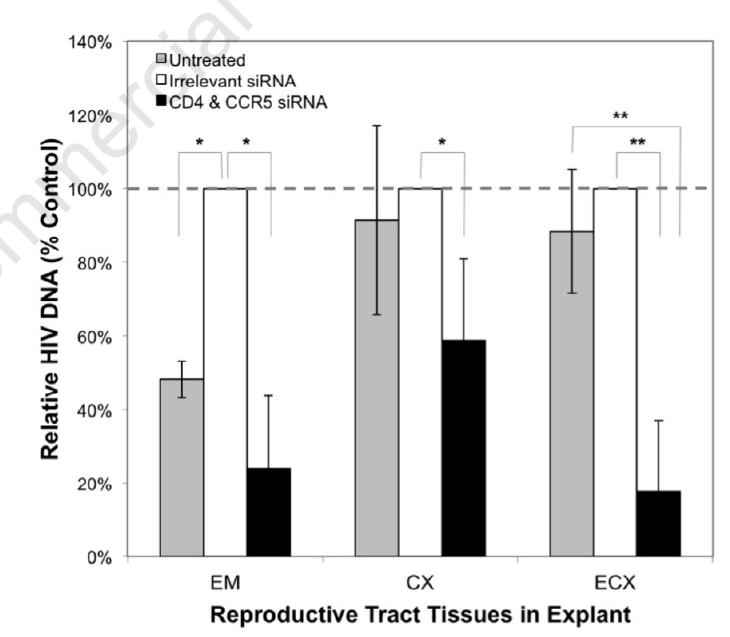
Figure 4. Nanoparticles containing CCR5 and CD4 specific siRNAs inhibit HIV-1 reverse transcription in female reproductive tract explants. Female reproductive tract tis- sue explants from the endometrium (EM), endocervix (CX) and ectocervix (ECX) were either left untreated (grey bars), or treated with nanoparticles containing irrelevant siRNA (20 nM, white bars), or the combination of both CCR5 and CD4-specific siRNA (10 nM each, black bars) for 48 hrs prior to exposure to HIV-1BaL. Explants were assessed for HIV-1 reverse transcripts 5 days after virus exposure. Data are displayed by setting the levels of HIV-1 DNA from the irrelevant siRNA treated explants to 100%. Data are a compilation from four subjects, each of which was assayed in triplicate. Error bars show the standard deviation of the means relative to the irrelevant siRNA control. The single asterisk (*) denotes statistically significant differences among bracketed bars at the P<0.05 level, and the double asterisks (**) denote significance at the P<0.005 level. Bars with no asterisks did not reach statistical significance at the 95% confidence